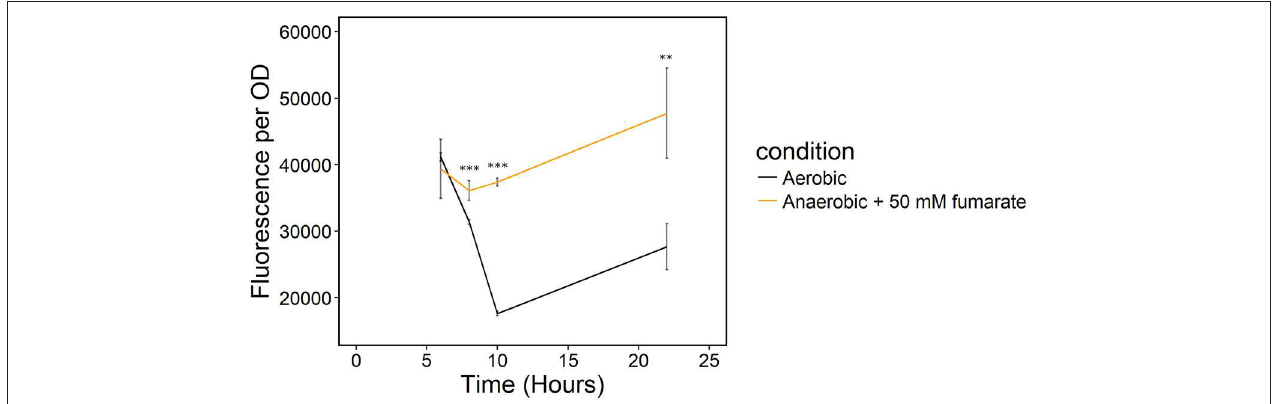
FIGURE 5 | Transition of S. oneidensis MR-1 with the Rex redox sensor growing in triplicate 50-mL cultures of LB from an oxic to an anoxic environment. The aerobic set (black) remained oxic and shaking and the anaerobic set (orange) of triplicates was given 50mM fumarate as a terminal electron acceptor when moved to an anoxic environment. ** p ≤ 0.01 and *** p ≤ 0.001 denote significance of difference from the aerobic culture.